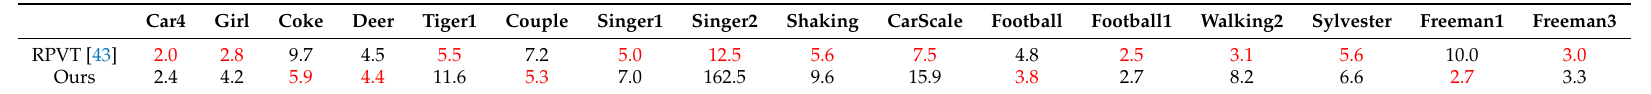
Table 3. Average center location error comparison with Real-time part-based visual tracking (RPVT) [43] on 16 sequences in OTB-50. The red number is the best